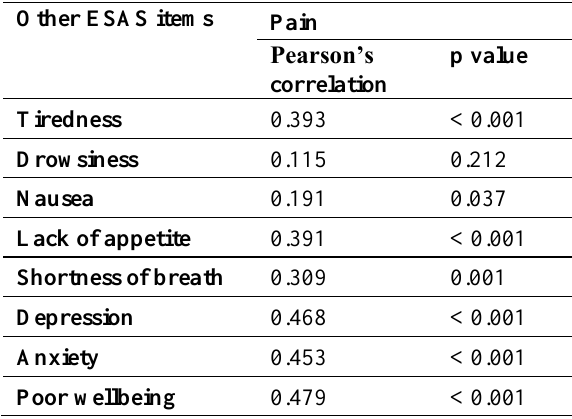
Table 3. Correlation between pain score and other ESAS items